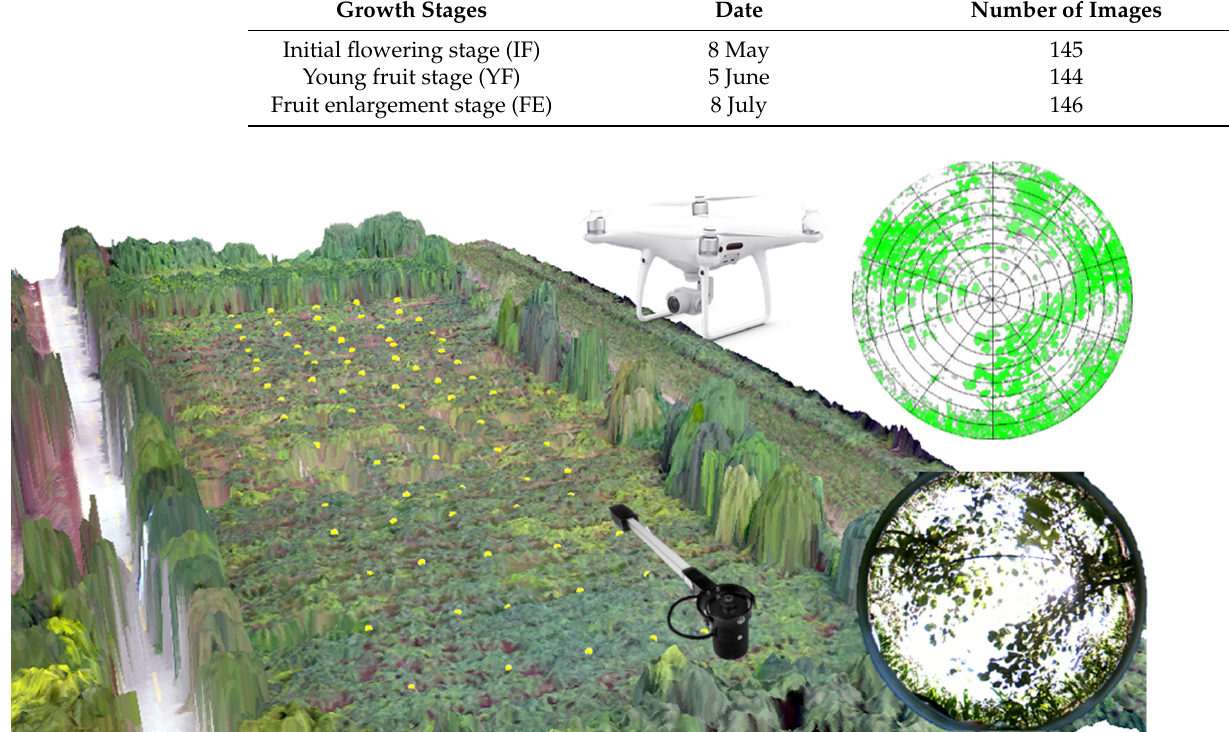
Figure 2. Three-dimensional visualization of sampling sites and equipment in the kiwifruit or-